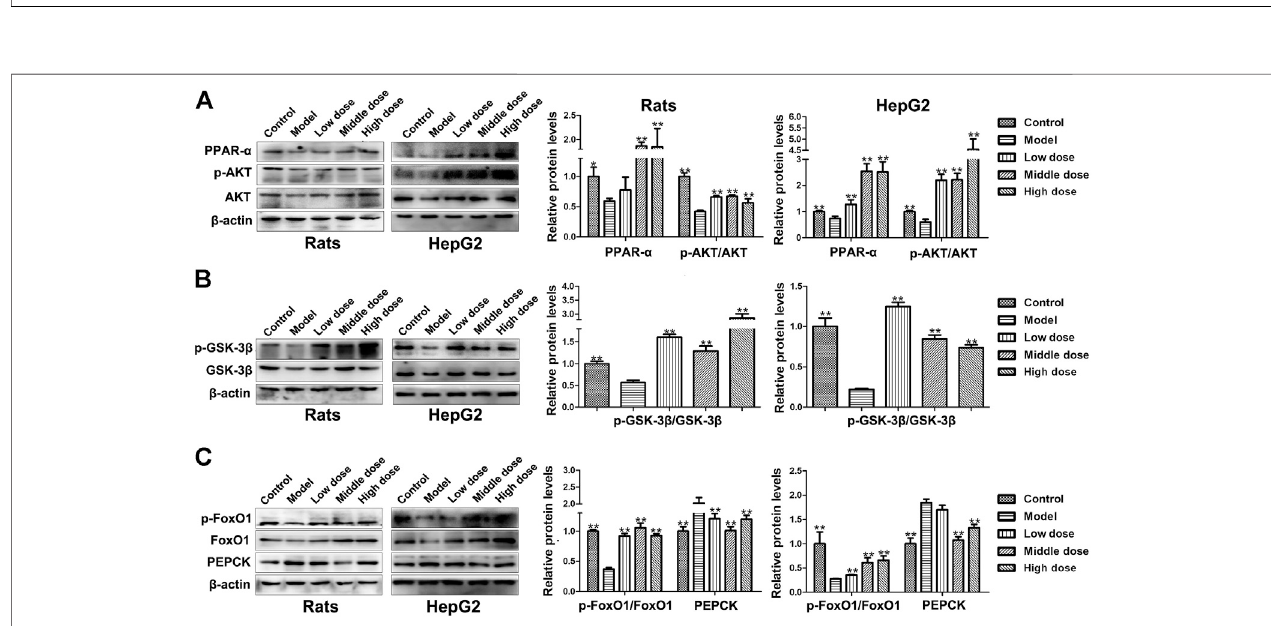
FIGURE 6 | Effect of HSAV on the expression of downstream proteins of PGC-1 α by Western blot. (A) The expression levels of PPAR- α , AKT and p -AKT; (B) the expression levels of GSK-3 β and p -GSK-3 β ; (C) the expression levels of FoxO1, p -FoxO1 and PEPCK. Data are presented as the mean ± SD (n (cid:2) 3). * p < 0.05 and ** p < 0.01 compared with model